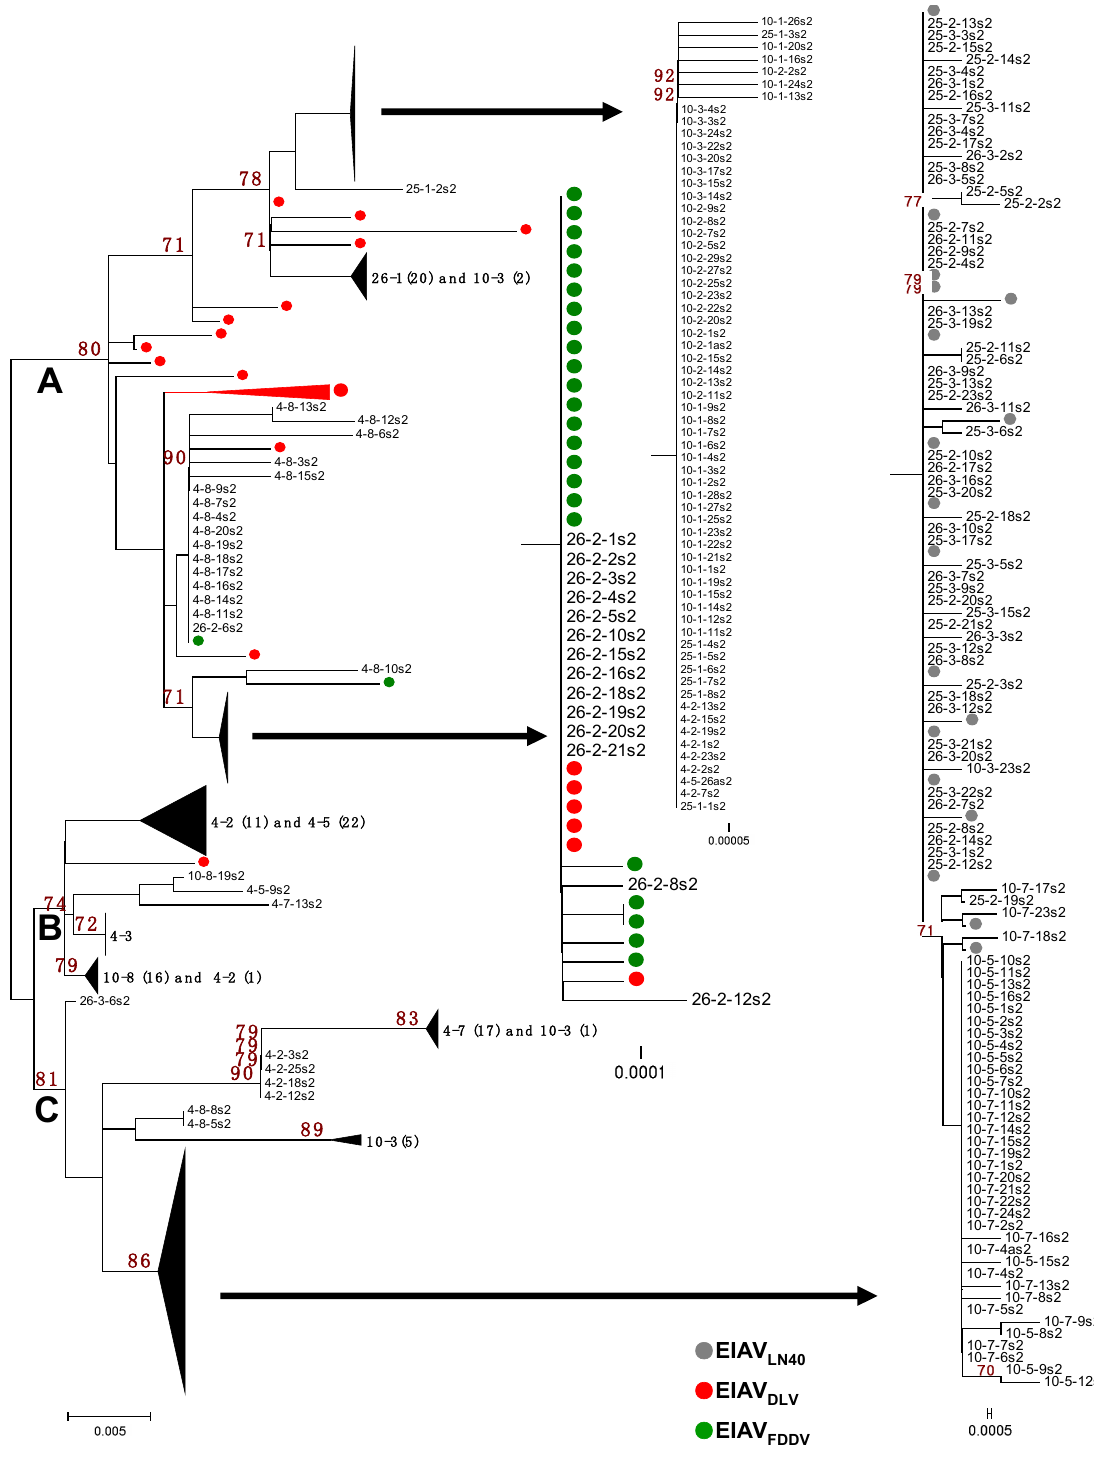
Figure 2. Phylogenetic analysis of the S2 gene. Sequences include the EIAV LN40 stock virus, plasma viral RNA obtained from four EIAV LN40 -infected horses, the donkey monocyte-derived macrophage (MDM)-adapted vaccine strain EIAV DLV121 , and the donkey dermal (FDD) cell-attenuated vaccine strain EIAV FDDV13 . The phylogenetic trees were constructed by the neighbor-joining method, calculated with the Kimura 2 parameter in MEGA software (version 5.0, Center for Evolutionary Functional Genomics Biodesign Institute, Arizona State University, Tempe, AZ, USA,